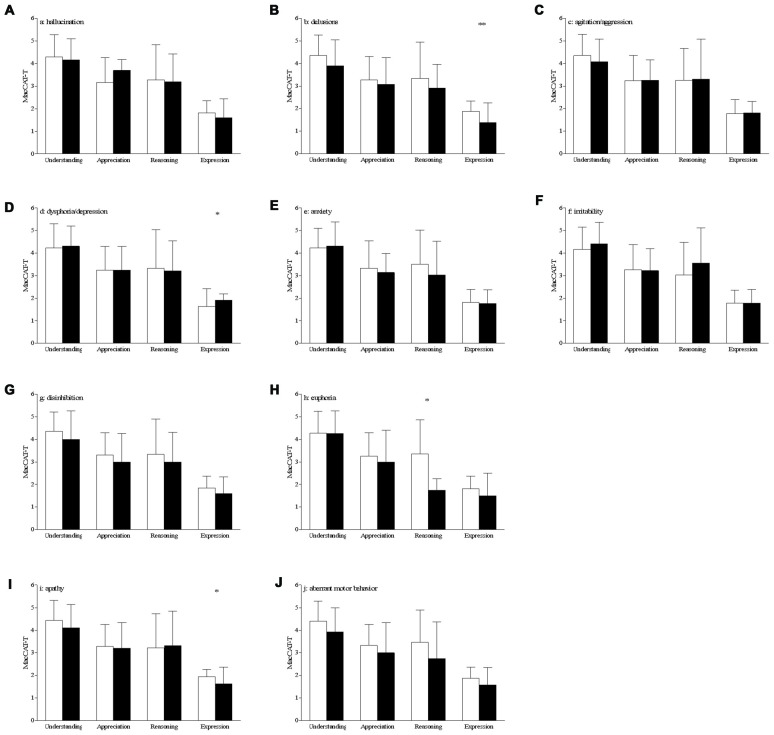
Differences on MacArthur Competence Tool for Treatment (MacCAT-T) subscales according to the presence of behavioral and psychological symptoms of dementia (BPSD; A–J) bar graph of the mean with standard deviation of the MacCAT-T subscales per subscale of the neuropsychiatric inventory (NPI). White bars represent the patients with a score of 0 on that domain, black bars those patients with a score of 1 or higher on that domain; *p < 0.05, **p < 0.01; significant differences can be seen for delusions, dysphoria and apathy (expression of choice) and for euphoria (reasoning).